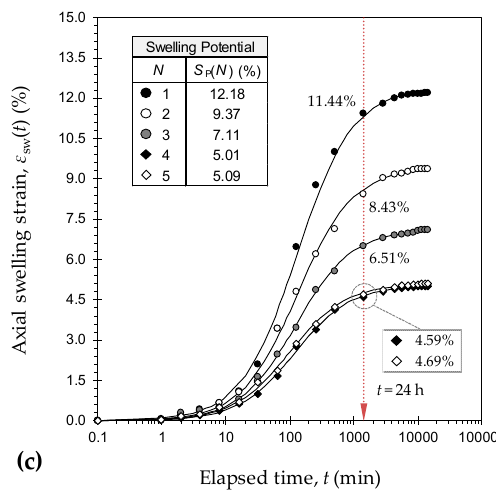
Figure 3. Swell–time curves during alternate wetting cycles: ( a ) C; ( b ) CRA; and ( c ) CRB.